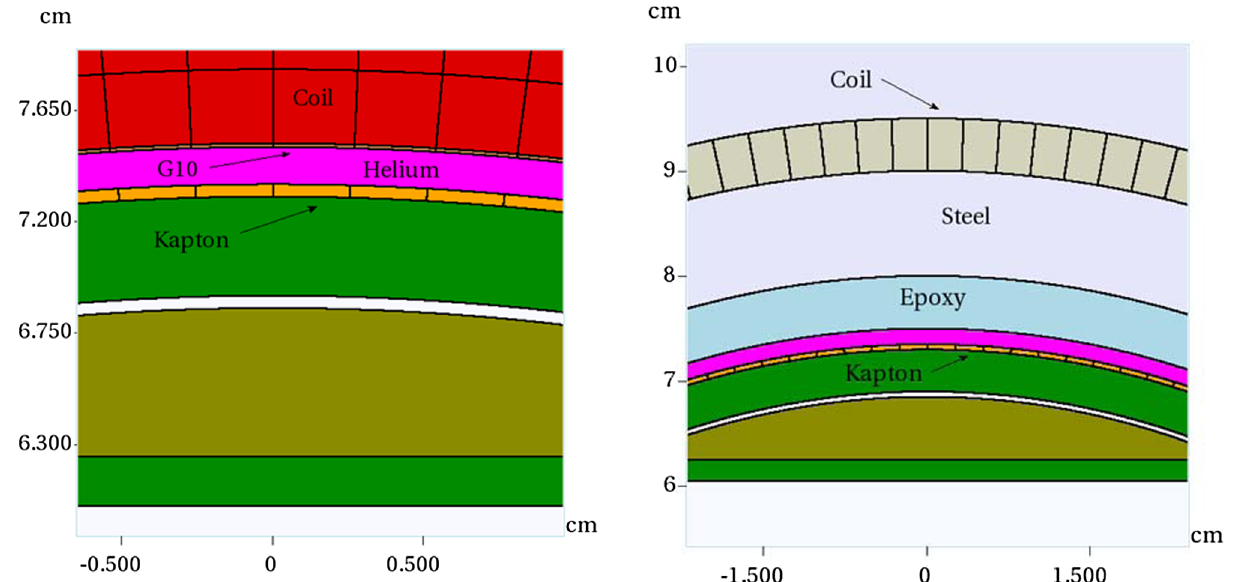
FIG. 6. Cross-sectional view of the FLUKA - MARS model fragments with kapton cells in Q1-Q3 quadrupoles (left) and MCBX correctors